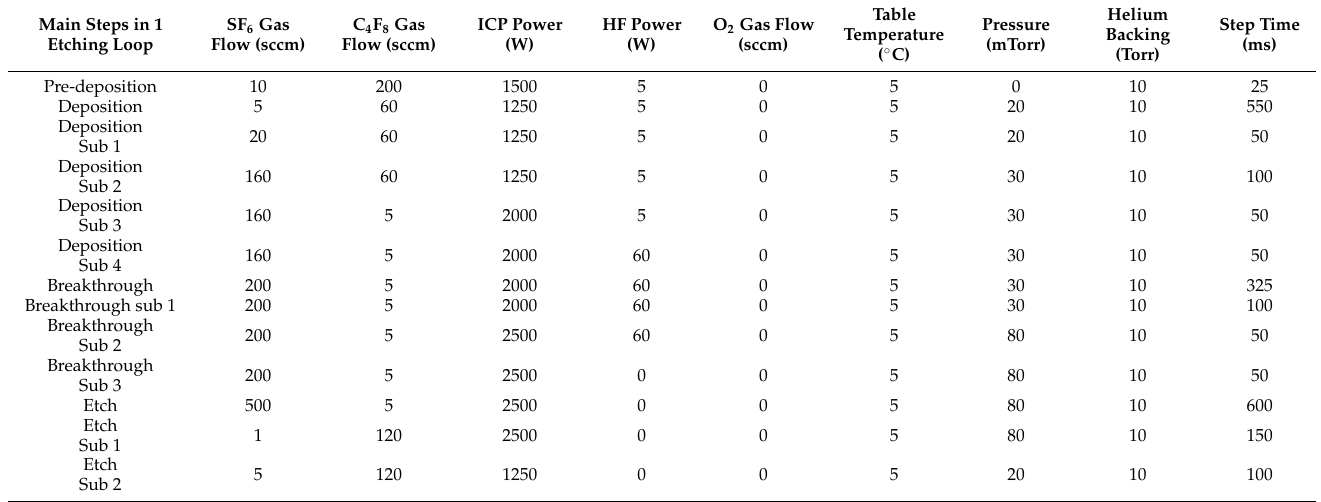
Table 1. Nanoparticles-assisted Bosch